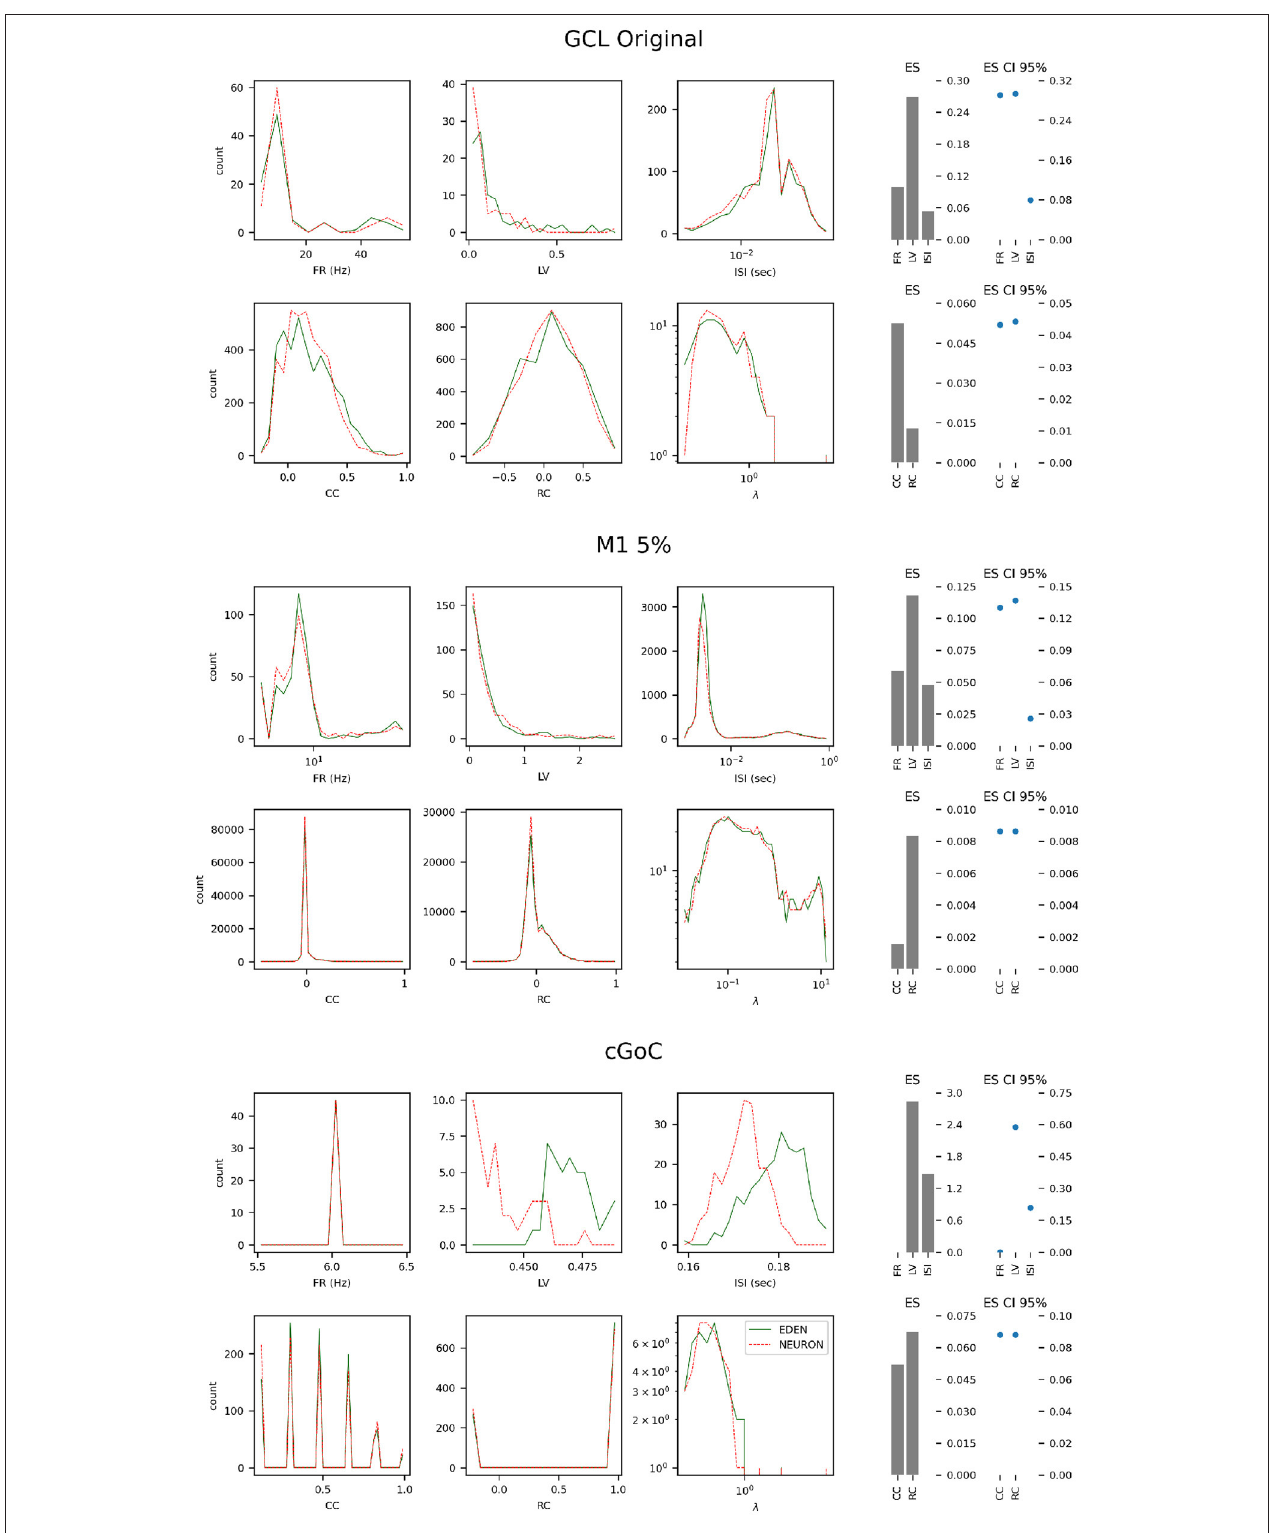
FIGURE 9 | Histograms of neural activity metrics for each network used in the performance benchmarks. FR, firing rate; LV, local variation; ISI, inter-spike interval; CC, short-time firing correlation; RC, rate correlation; ( λ ), correlation eigenvalue. For each simulated network, the solid green line outlines the distribution of metric values when using EDEN, and the overlaid dashed red line outlines the distribution when using NEURON. On the right, the effect size (ES) and its confidence interval is shown for each applicable metric.